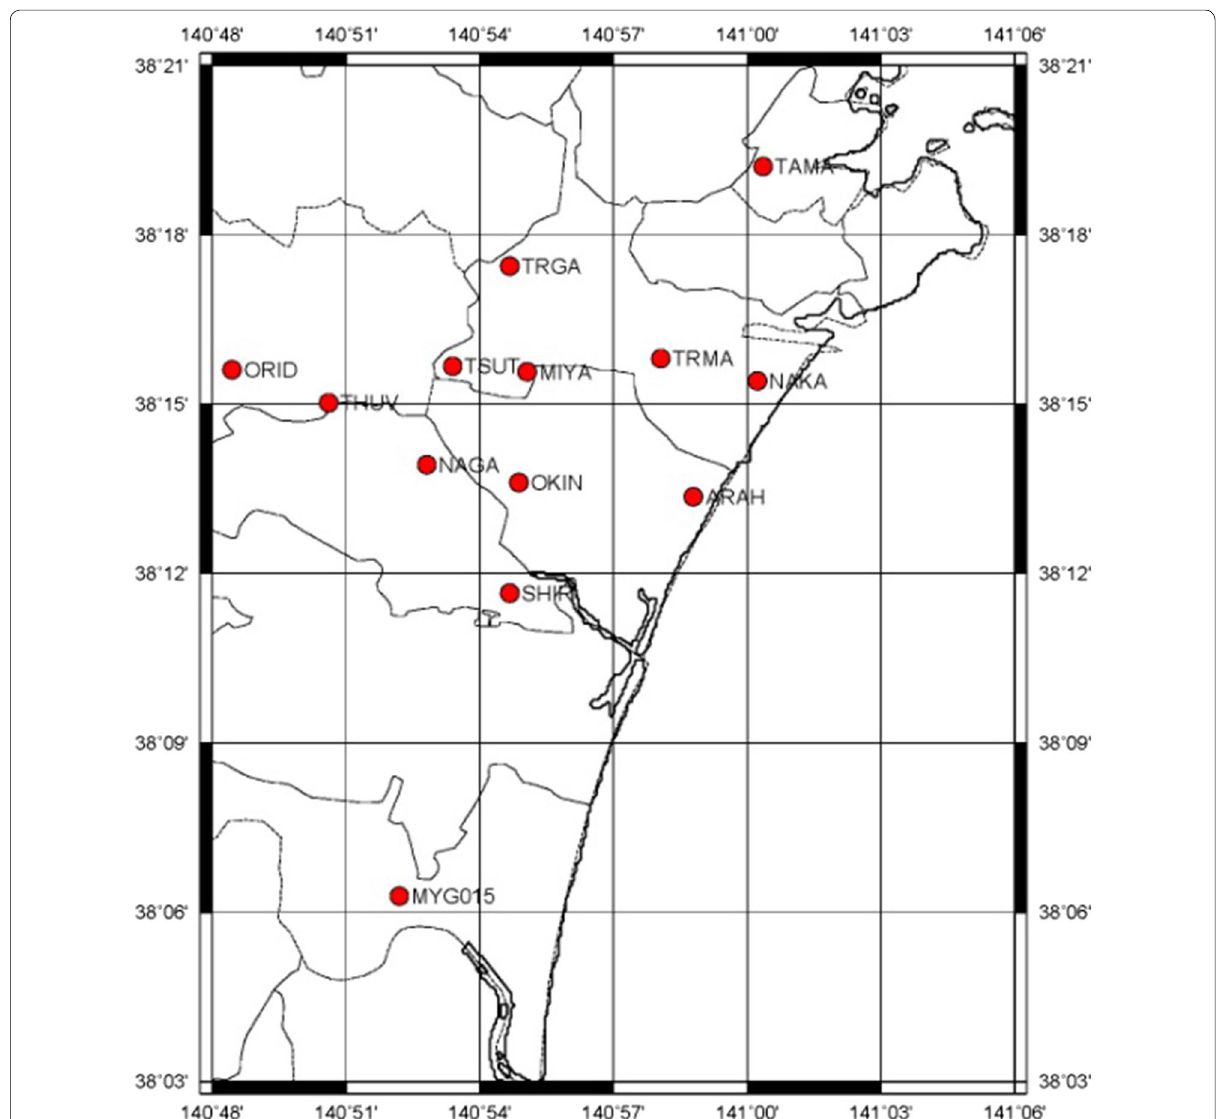
Fig. 18 Microtremor and earthquake ground motion measurement sites in and around Sendai